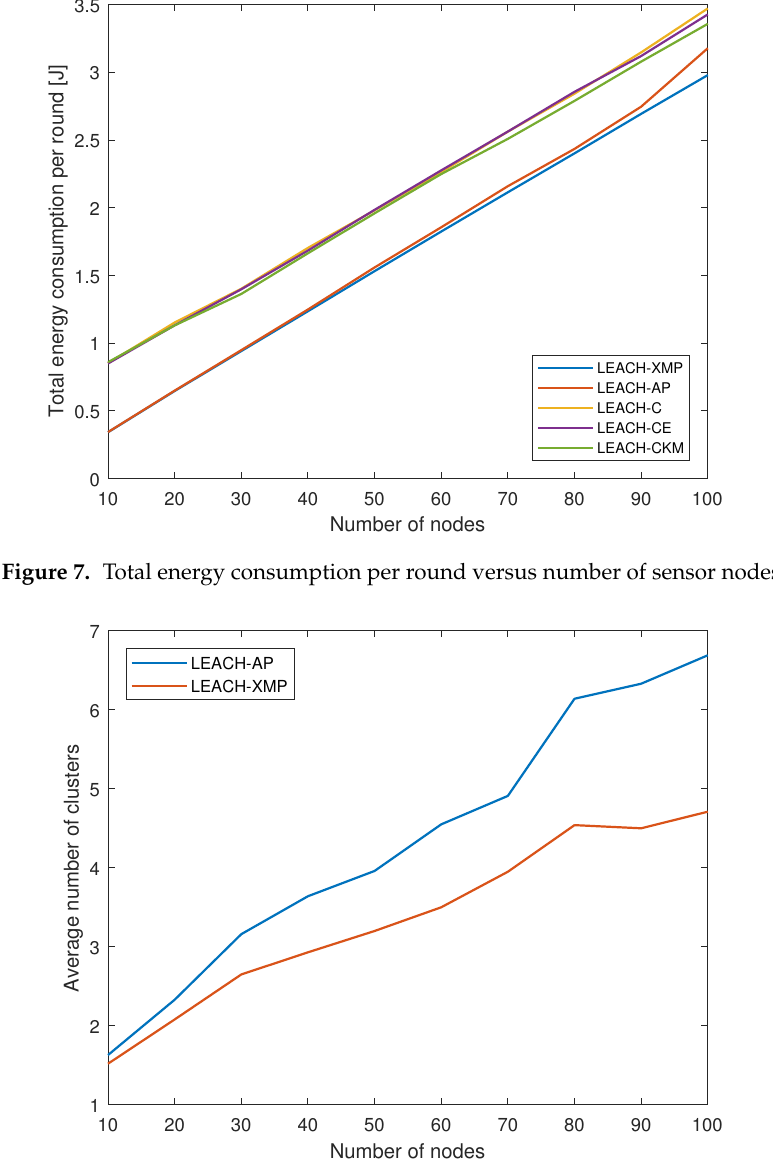
Figure 8. Number of clusters versus number of sensor